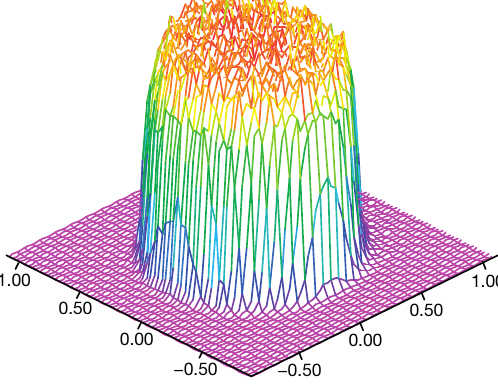
Figure 3. Isometric representation of a laser beam intensity